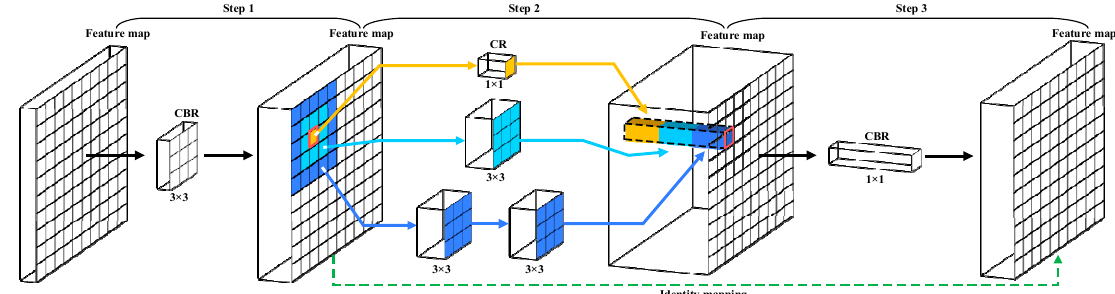
Figure 2. The general structure of the MFF. The graphic does not show the specific structural changes caused by the skip connections and the dilated convolution. Meanwhile, different colors are utilized to emphasize the vital structures.